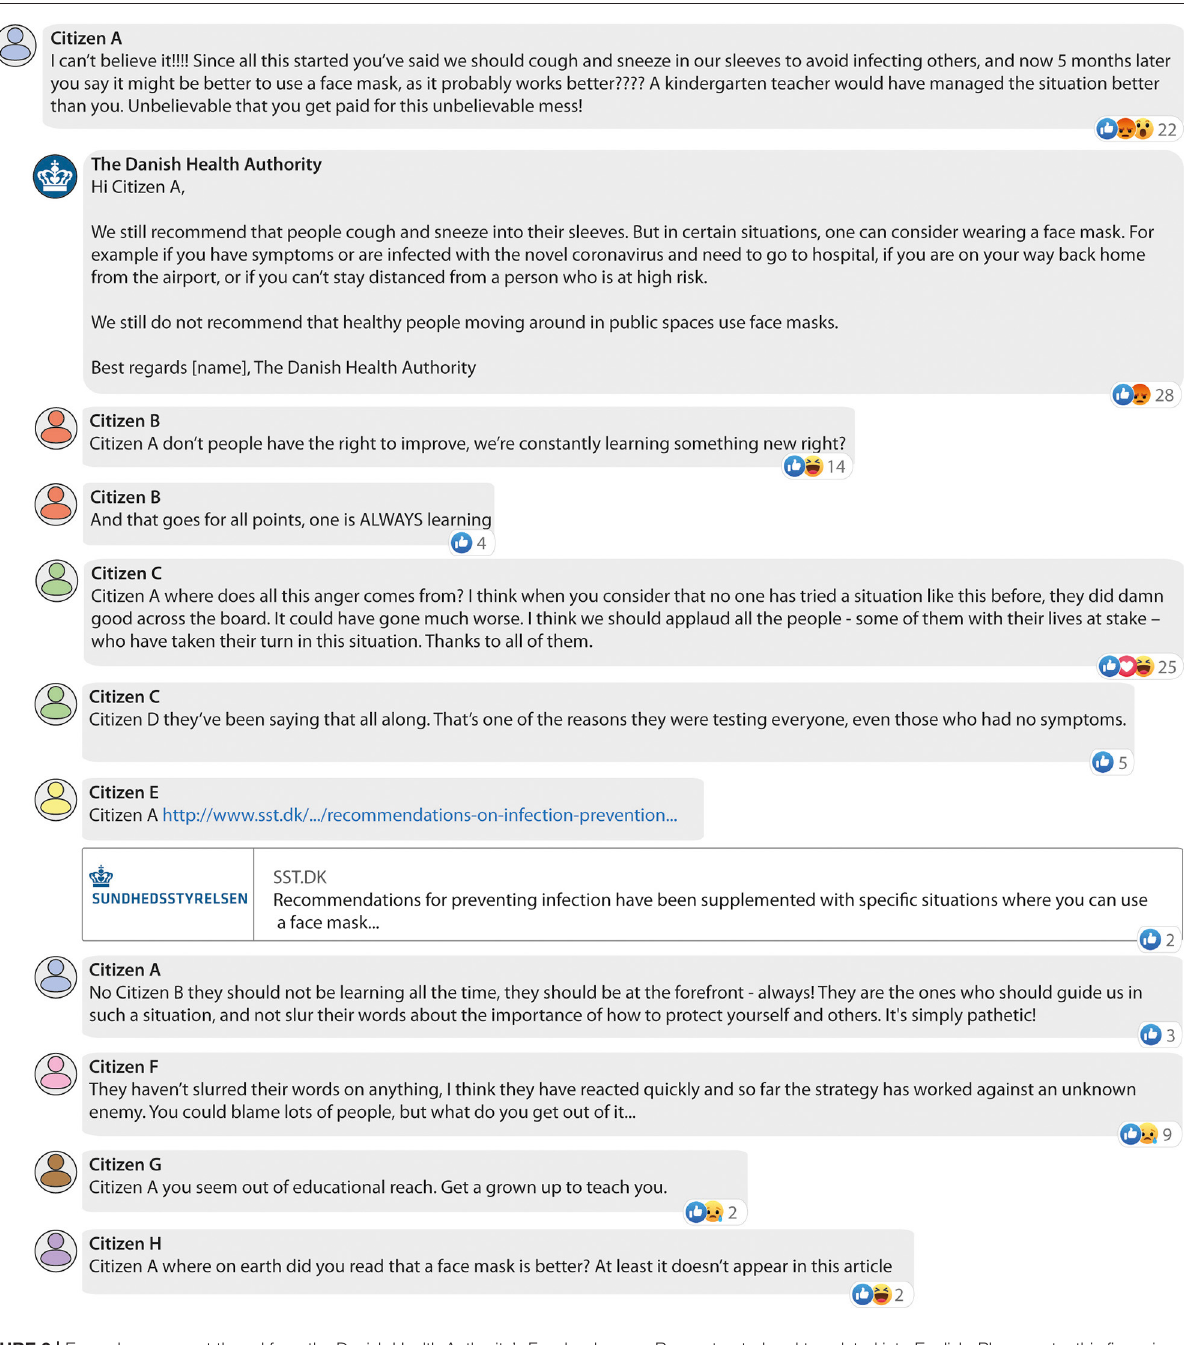
Frontiers in Communication |